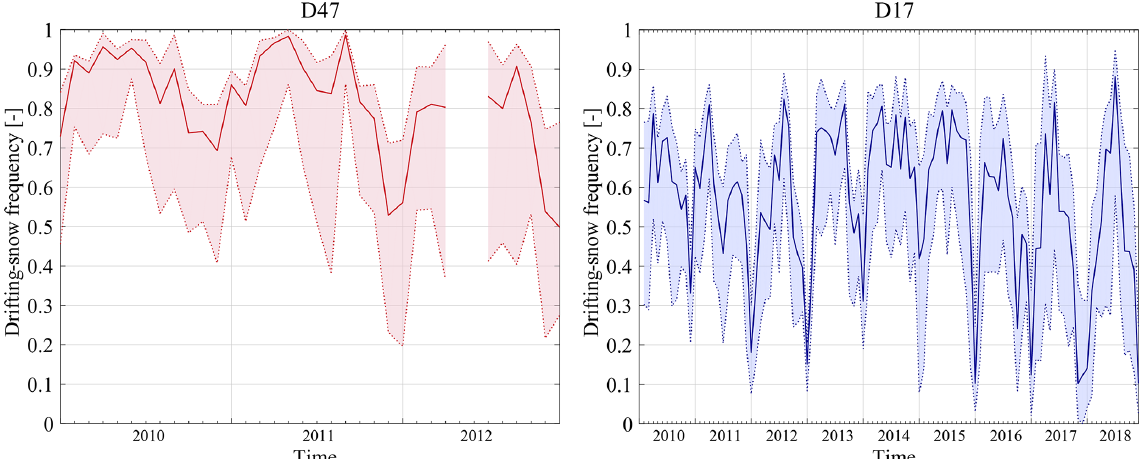
Figure 2. Seasonal variability in drifting-snow frequency as recovered by the 2G-FlowCapt™ instruments. Shaded areas correspond to frequencies respectively computed using a relaxed and a stricter confidence threshold of 10 − 4 and 10 − 2 kgm − 2 s − 1 and are shown as a measure of uncertainty. The absence of data at D47 during May and June 2012 is due to instrument malfunction.